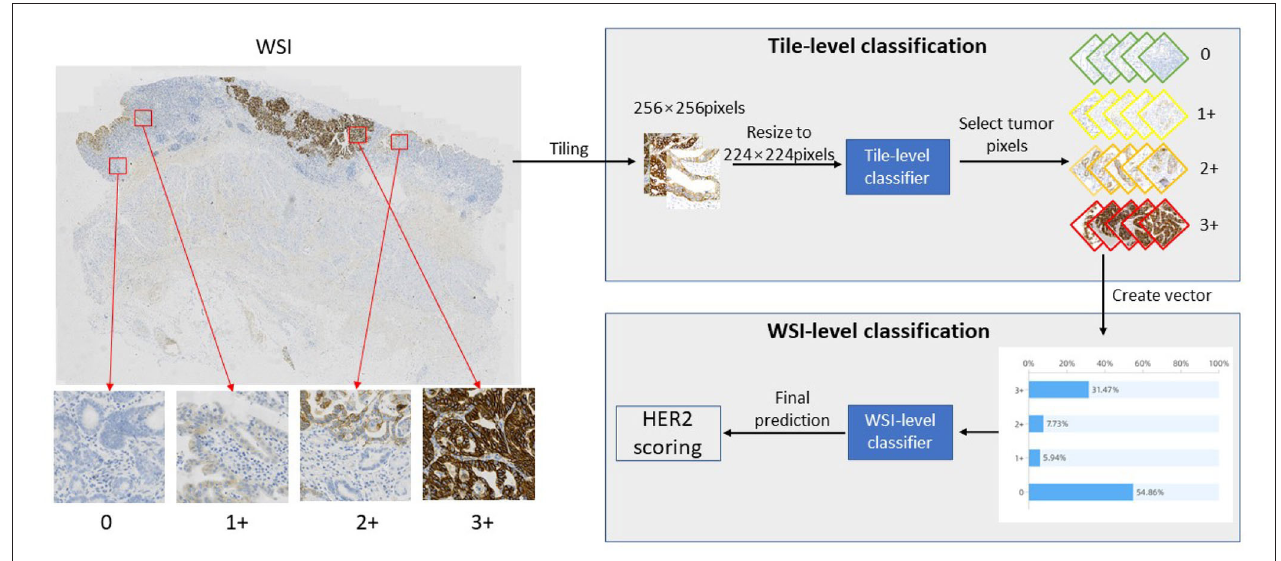
FIGURE 1 | The Whole Framework of Quantification Algorithm for HER2 scoring of gastric